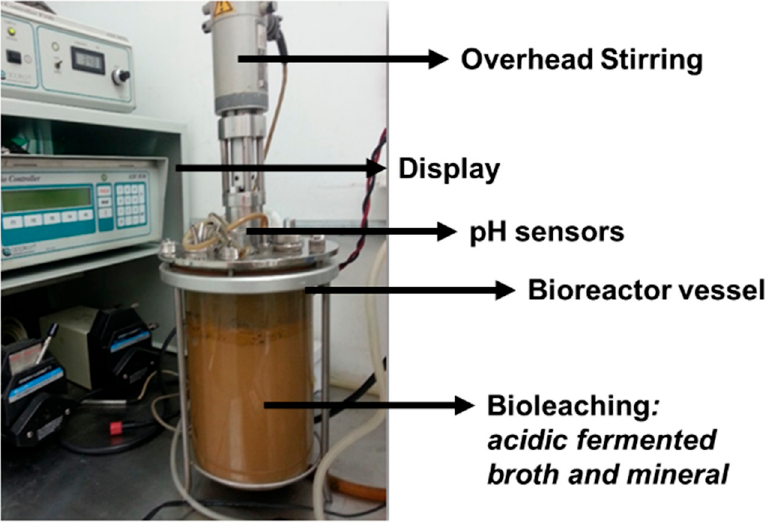
Figure 1. Bioprocess system.